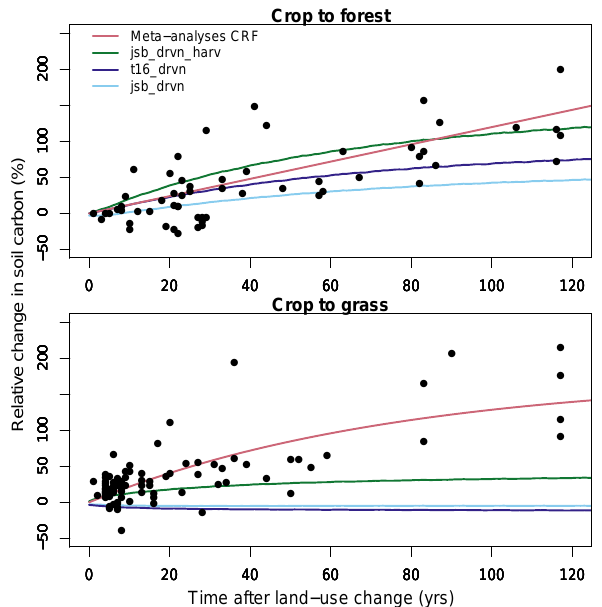
Figure 3. Mean simulated transient relative changes in soil carbon compared to the individual observations in the meta-analyses